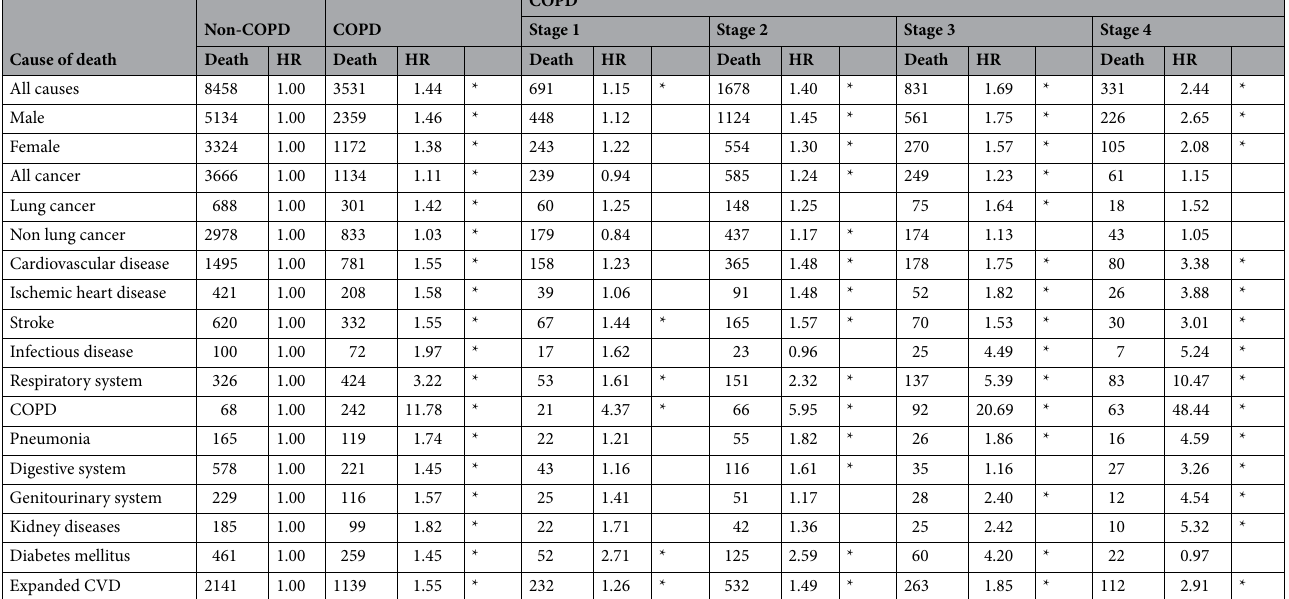
Table 3. Mortality risk for different chronic obstructive pulmonary disease stages by cause of death. HRs are compared with the reference group of all Non-COPD. CVD cardiovascular disease. Expanded CVD: CVD